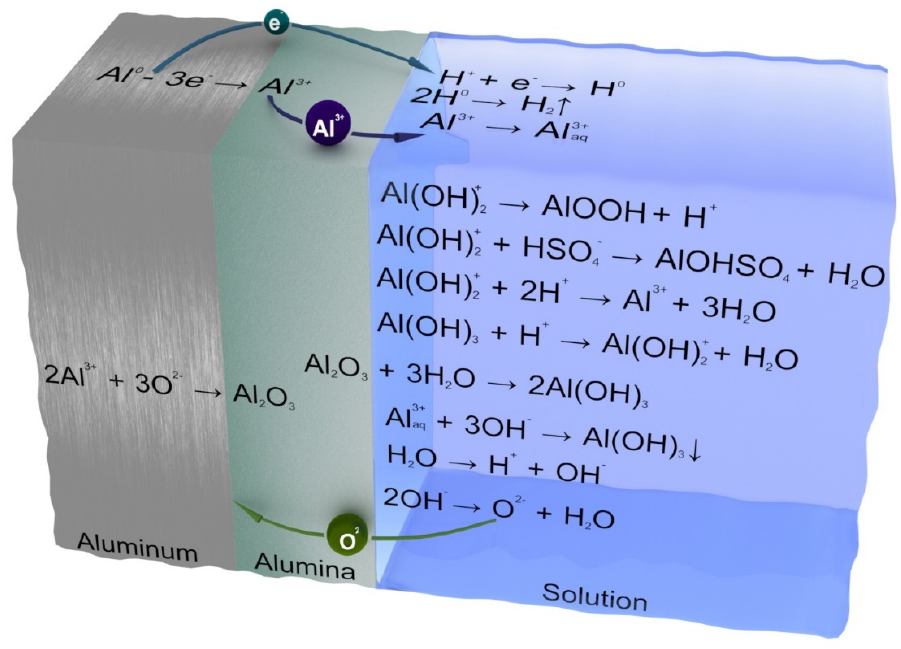
Figure 2. Schematic 3D views of aluminum’s mechanism of dissolution in aqueous solutions.